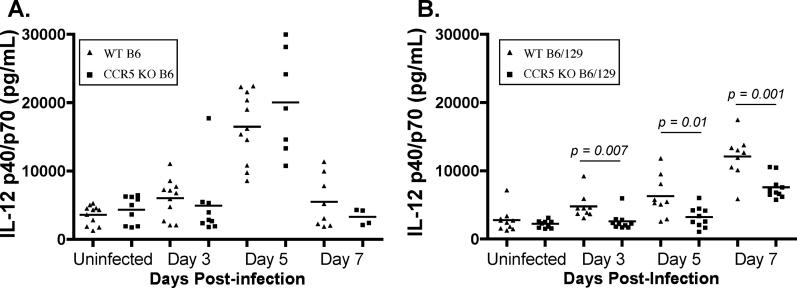
Serum IL-12 Levels for Wild-Type and CCR5−/− MiceWild-type (WT) and CCR5−/− (CCR5 KO) mice in the C57BL/6 background (A) and C57BL/6x129 background (B) are represented. Serum IL-12 levels were measured by ELISA before infection or at days 3, 5, and 9 PI with 50 cysts of strain 76K T. gondii. Each data point was measured in duplicate and indicates IL-12 levels for an individual mouse. The bar represents the average at each time point. Statistics were performed using Student's t-test.